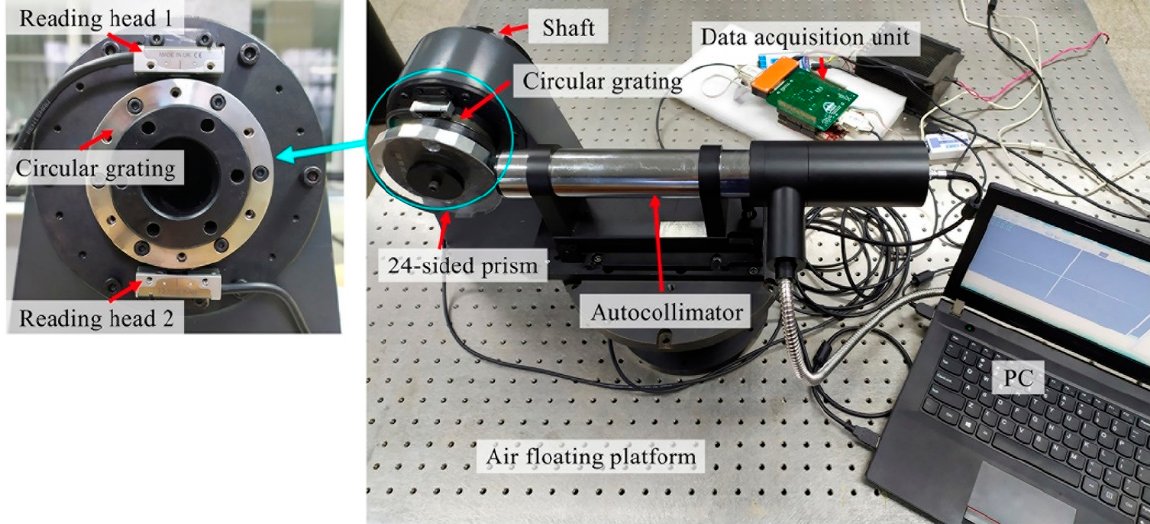
Figure 7. Experimental system for calibration and compensation of the angle measurement error of the circular grating.